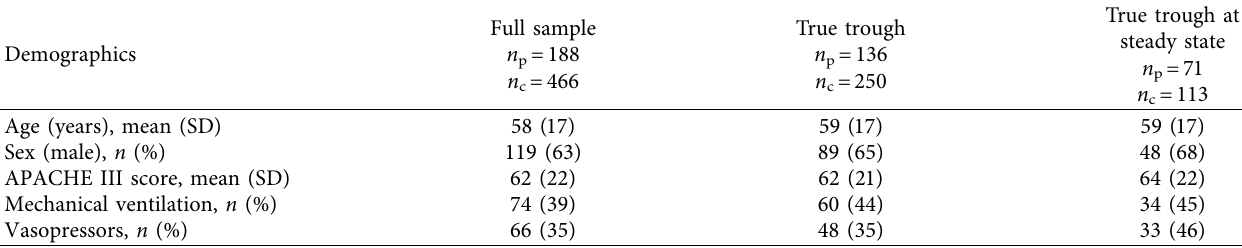
Table 1: Patient demographics.